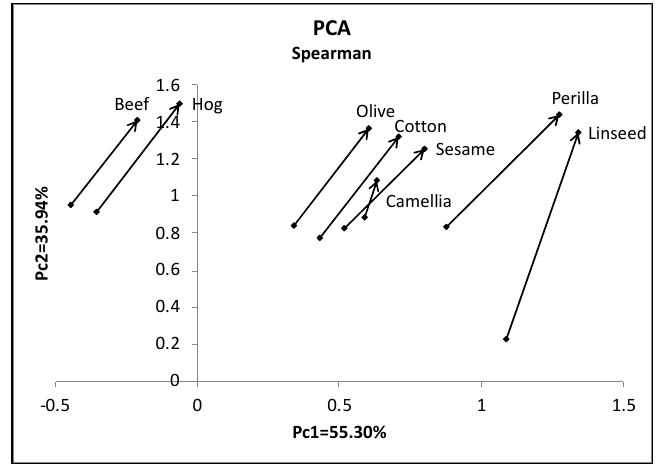
Figure 9. PCA result for Oils data.